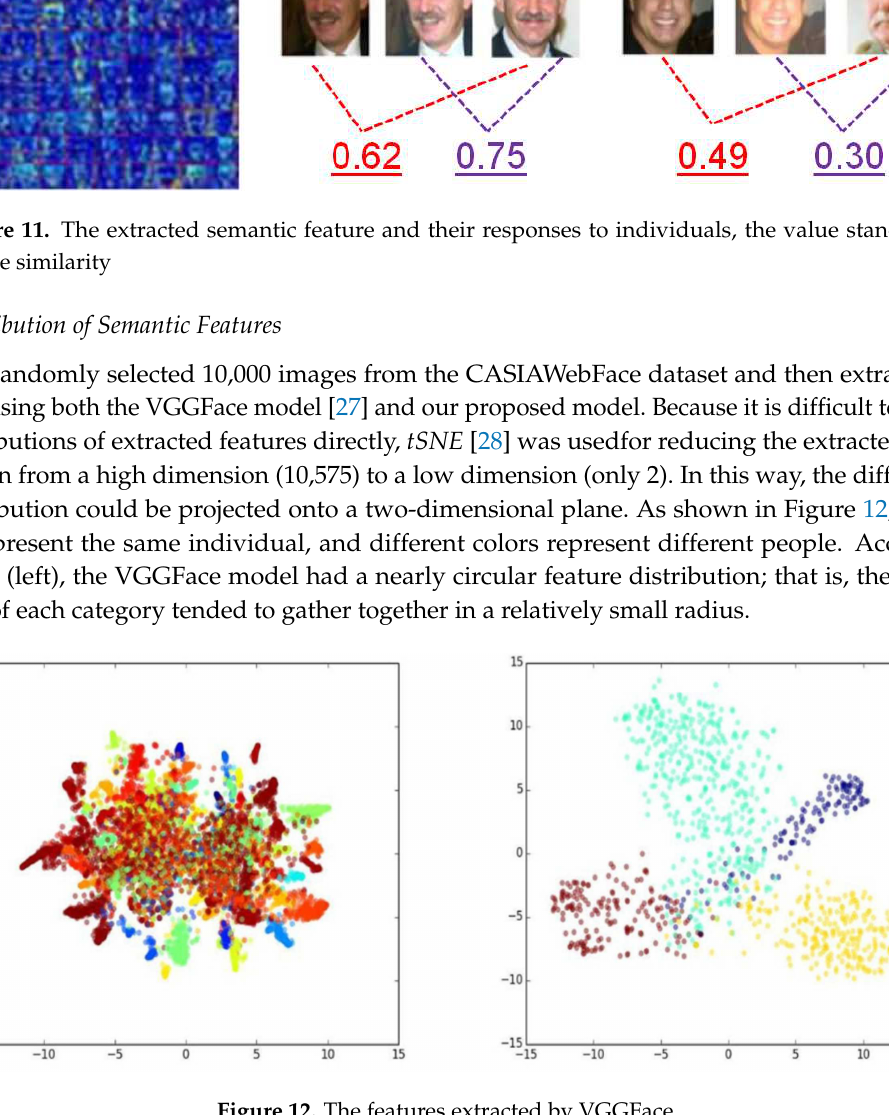
Figure 12. The features extracted by